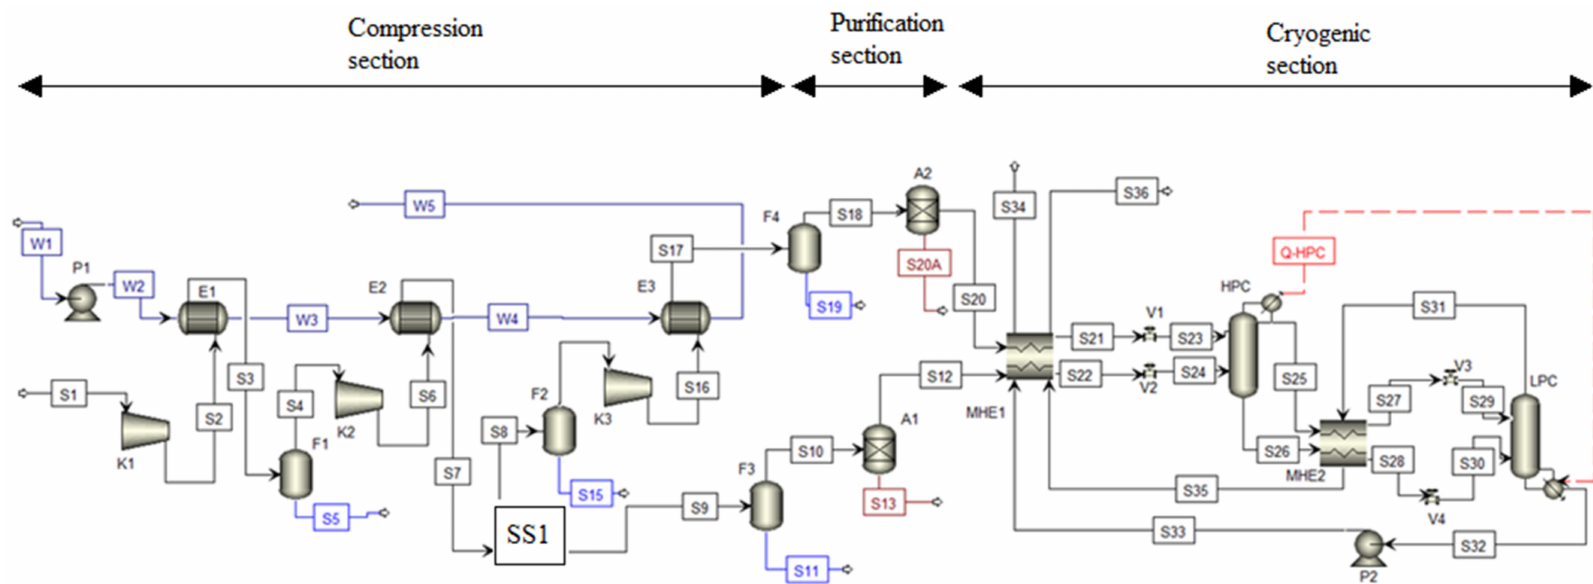
Figure 2. Process flow scheme of developed model in Aspen Plus ® V11. A: adsorber; E: heat exchanger; F: phase separator; HPC: high-pressure column; K: compressor; LPC: low-pressure column; MHE: multi-stream heat exchanger; Q: heat flow; P: pump; S: material stream; SS1: stream splitter; V: valve; W: cooling water